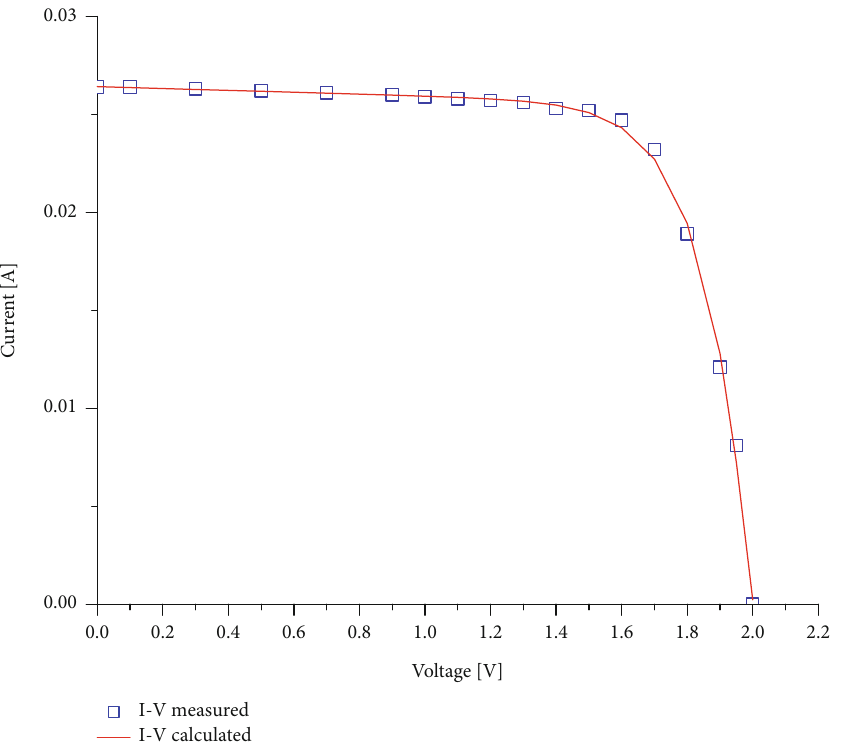
Figure 13: The I-V characteristics for STE 4/100 photovoltaic